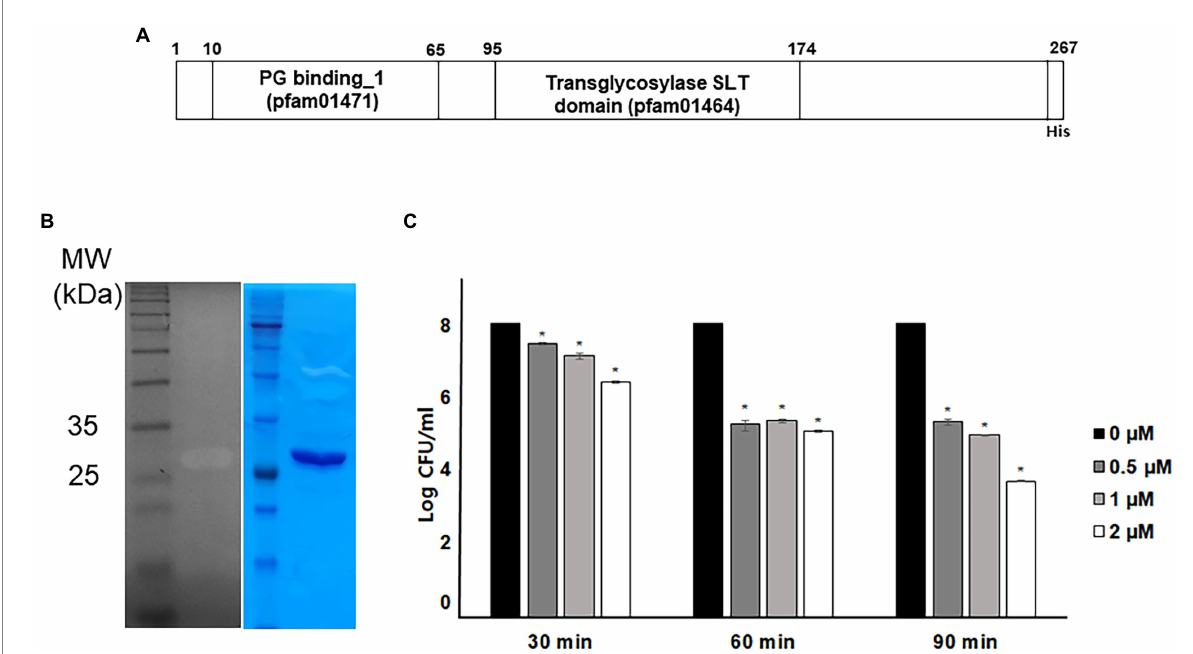
FIGURE 1 Antibacterial activity of recombinant endolysin LysPA90. (A) Domain structure of endolysin LysPA90. Numbers indicate amino acid positions. (B) Zymogram assay of purified recombinant endolysin LysPA90. Left; zymogram on E. coli ATCC8739, right; SDS-PAGE analysis of purified LysPA90. (C) Antibacterial activity of purified recombinant LysPA90 against E. coli ATCC8739. Antibacterial activity was tested at concentrations of 0 ~ 2 μ M for 30 to 90 min. Experiments were performed in triplicate. Data are expressed as mean ± standard